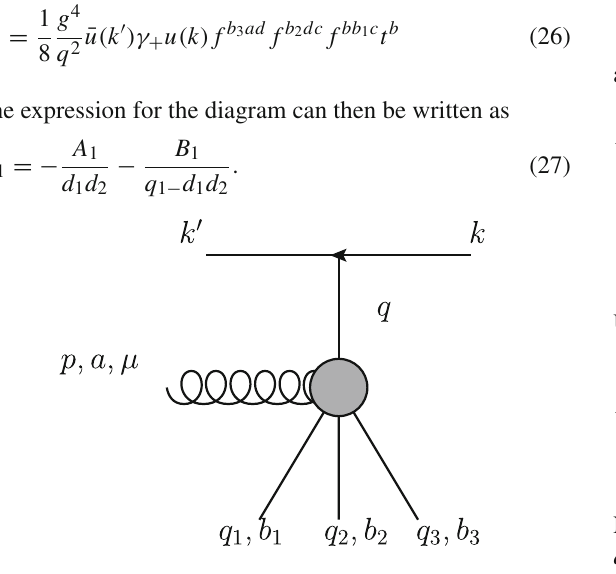
Fig. 2 The amplitude with the R → RRRP vertex